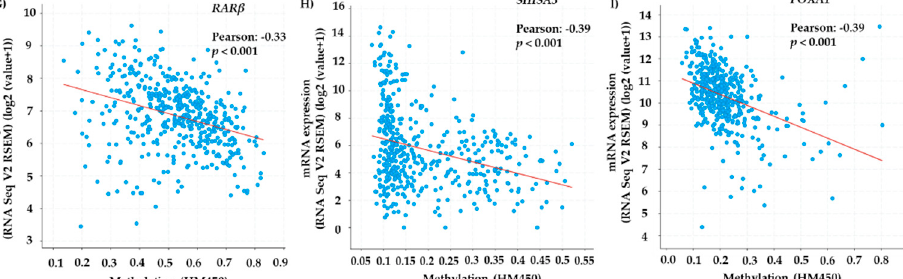
Figure 2. Association between mRNA expression and DNA methylation in lung adenocarcinoma tissues for ( A ) RASSF1A , ( B ) RASSF10 , ( C ) APC , ( D ) WIF-1 , ( E ) BRMS1 , ( F ) SLFN11 , ( G ) RAR β , ( H ) SHISA3 , ( I ) FOXA1 gene based on TCGA analysis within cBioPortal datasets.